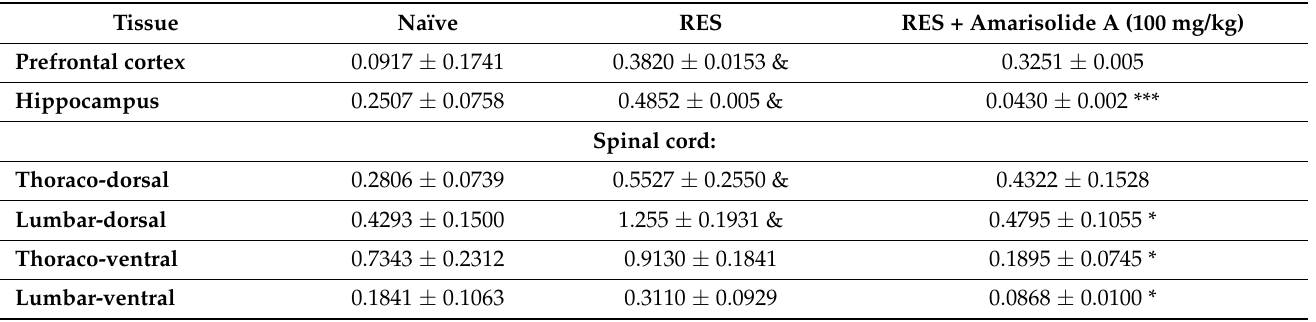
Table 1. IL-1 β levels expressed in pg/mg of nervous tissue from rats with and without fibromyalgia and in the presence of amarisolide